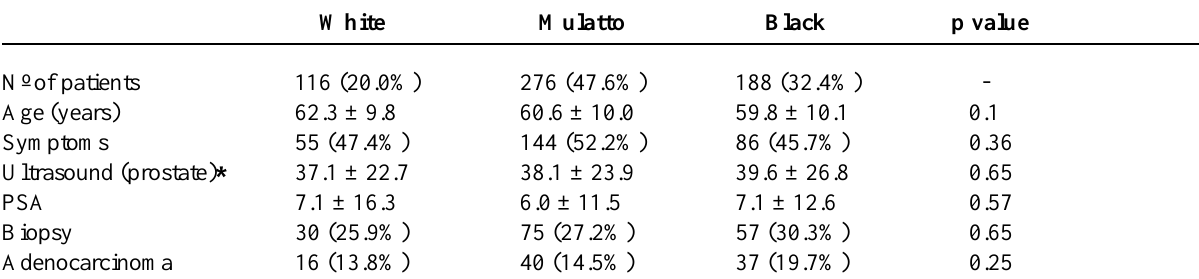
Table 2 – Some clinical-pathological characteristics of 580 patients according to race.